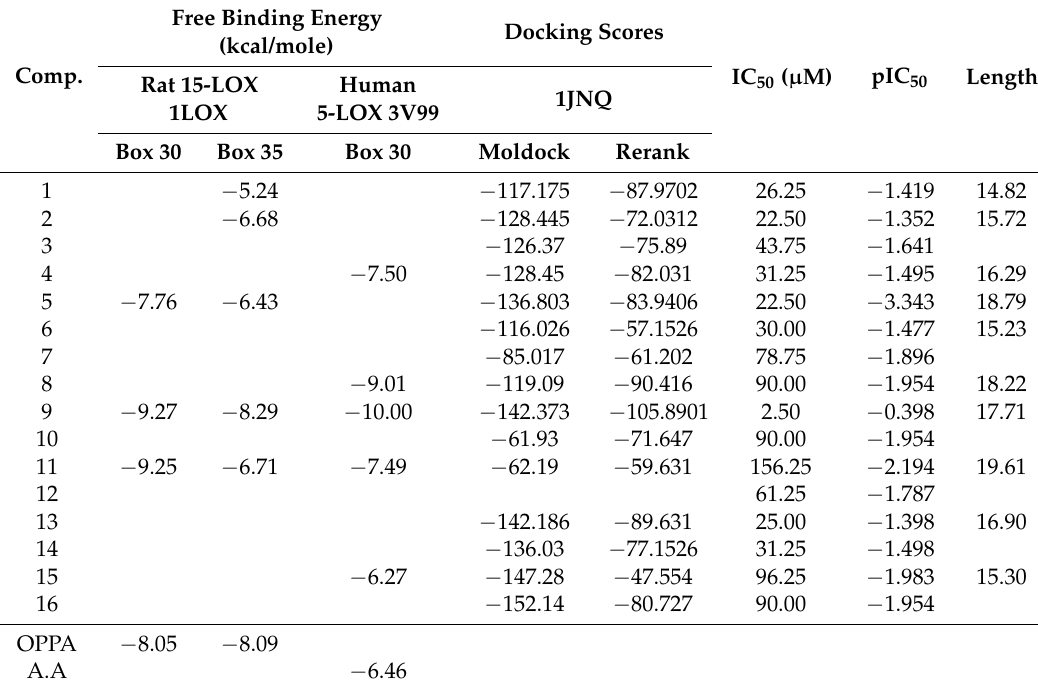
Table 5. Results of docking analysis to the rat 15-LOX, 1LOX, to human 5-LOX, 3V99 and the soybean LOX-3, 1JNQ, using different target center and box dimensions. Free Binding Comp.